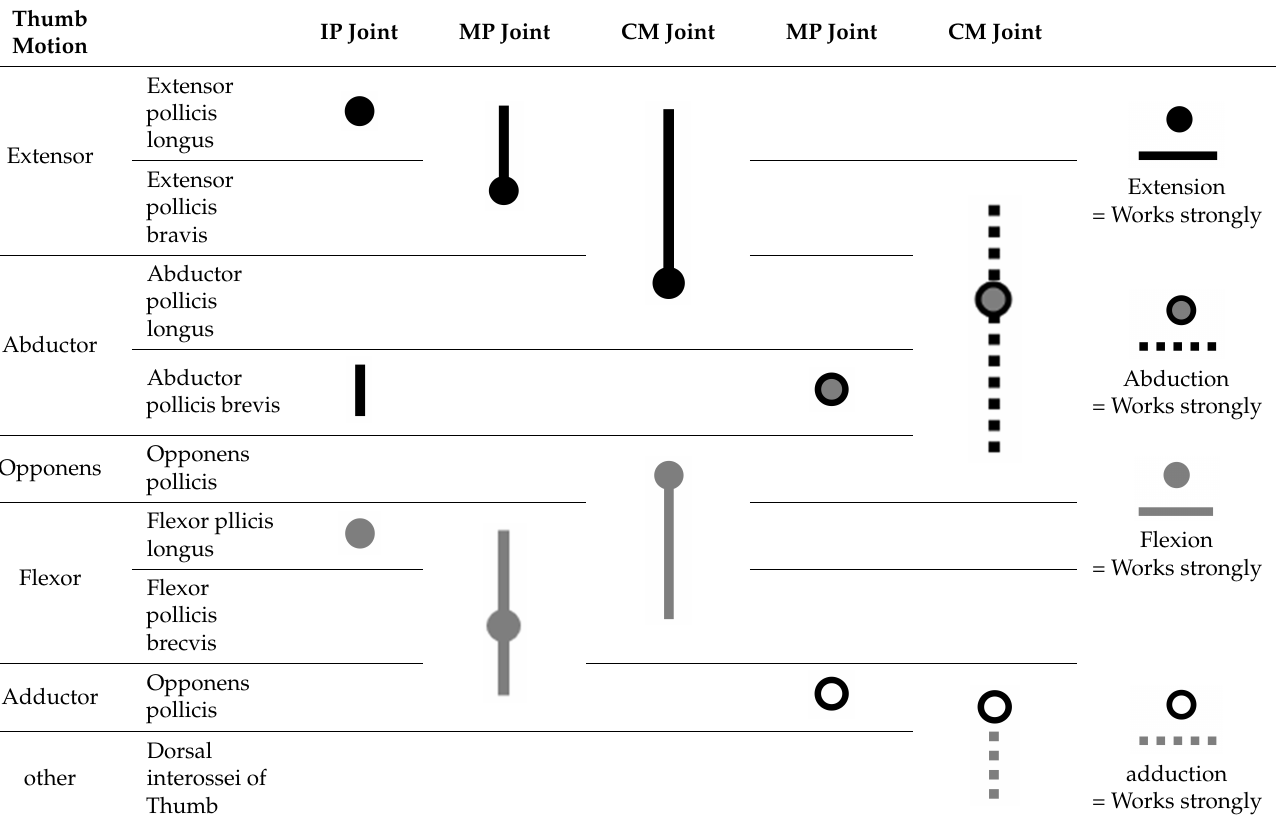
Table 4. Muscles involved in thumb